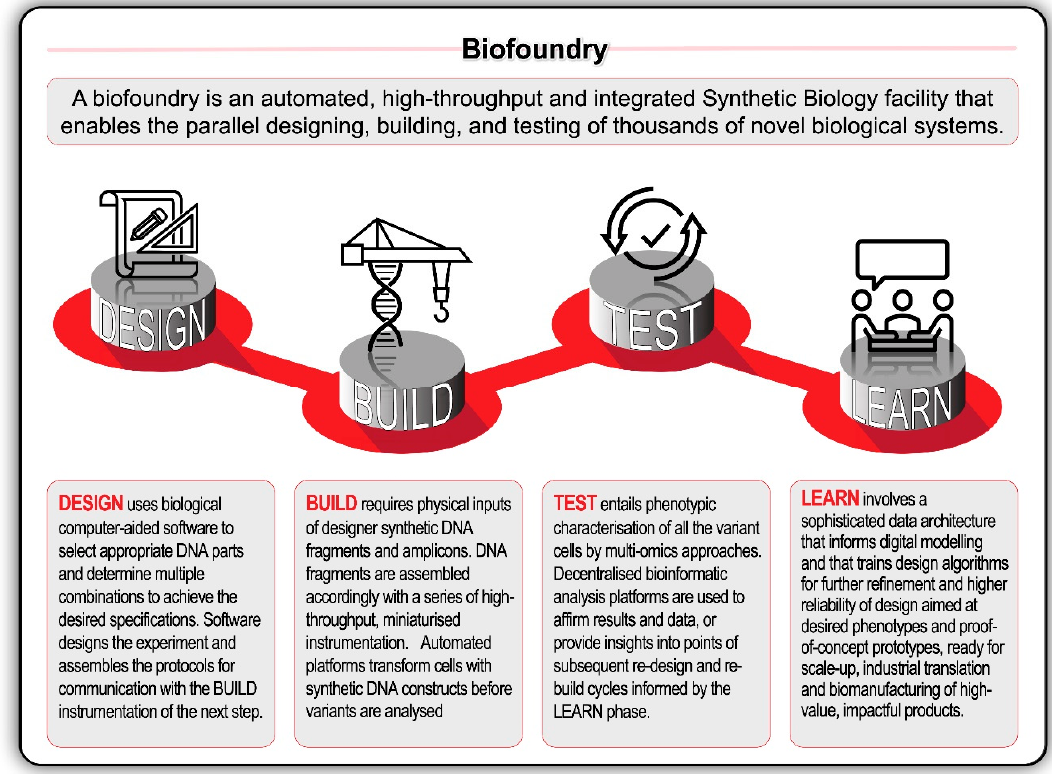
Figure 5. The application of design-build-test-learn (DBTL) biological engineering cycle can be accelerated in high-throughput, automated biofoundries with robotic workflows and technology synthetic biology platforms. Recent rapid advances in high-throughput DNA sequencing (reading) and DNA synthesis (writing and editing) techniques are enabling the design and construction of new biological parts (genes), devices (gene networks), and modules (biosynthetic pathways), and the redesign of biological systems (cells and organisms) for useful purposes.